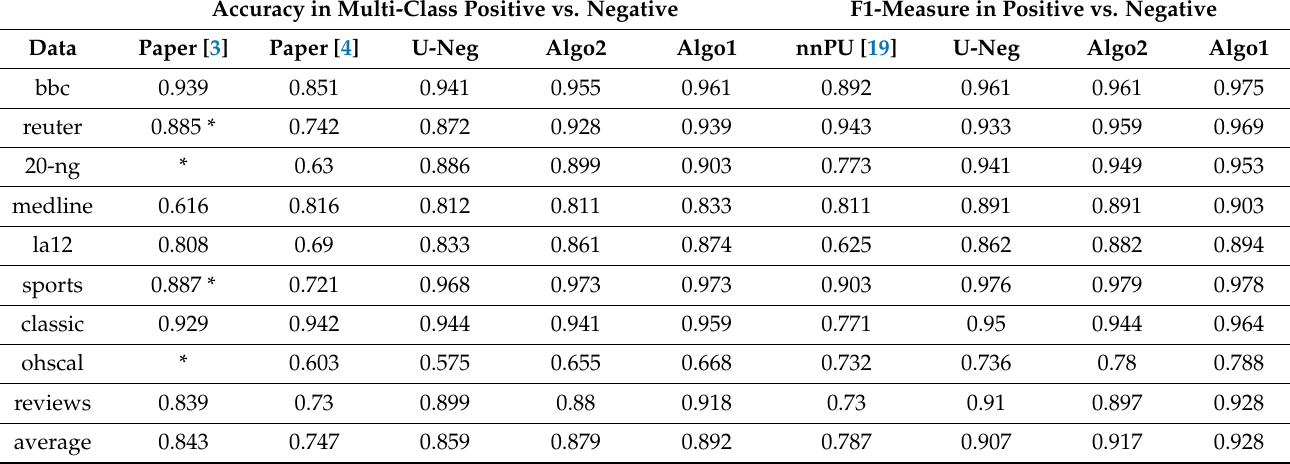
Table 2. Performance comparison by accuracy and